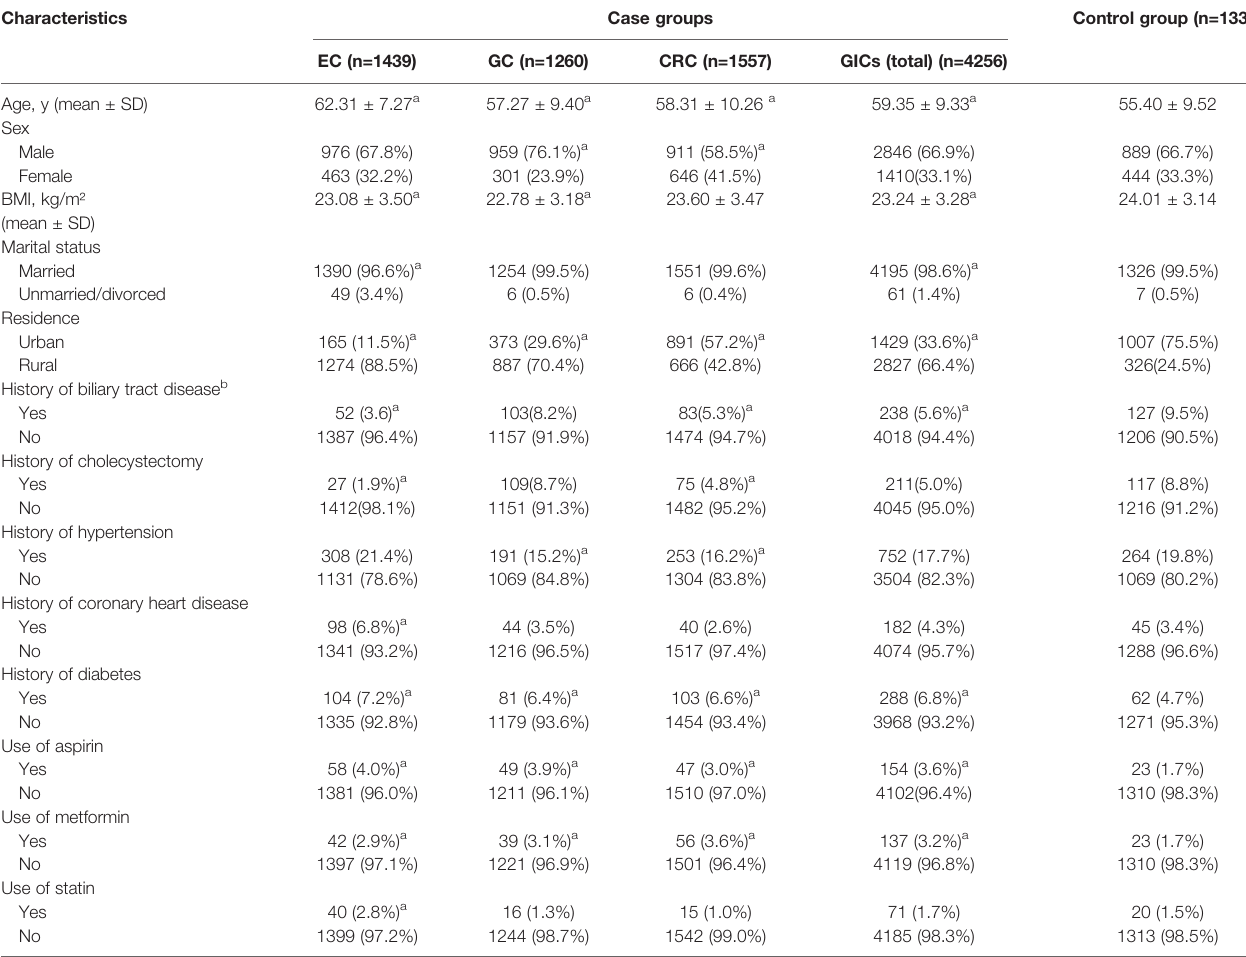
TABLE 1 | Characteristics of the study participants in the case group and the control group, numbers